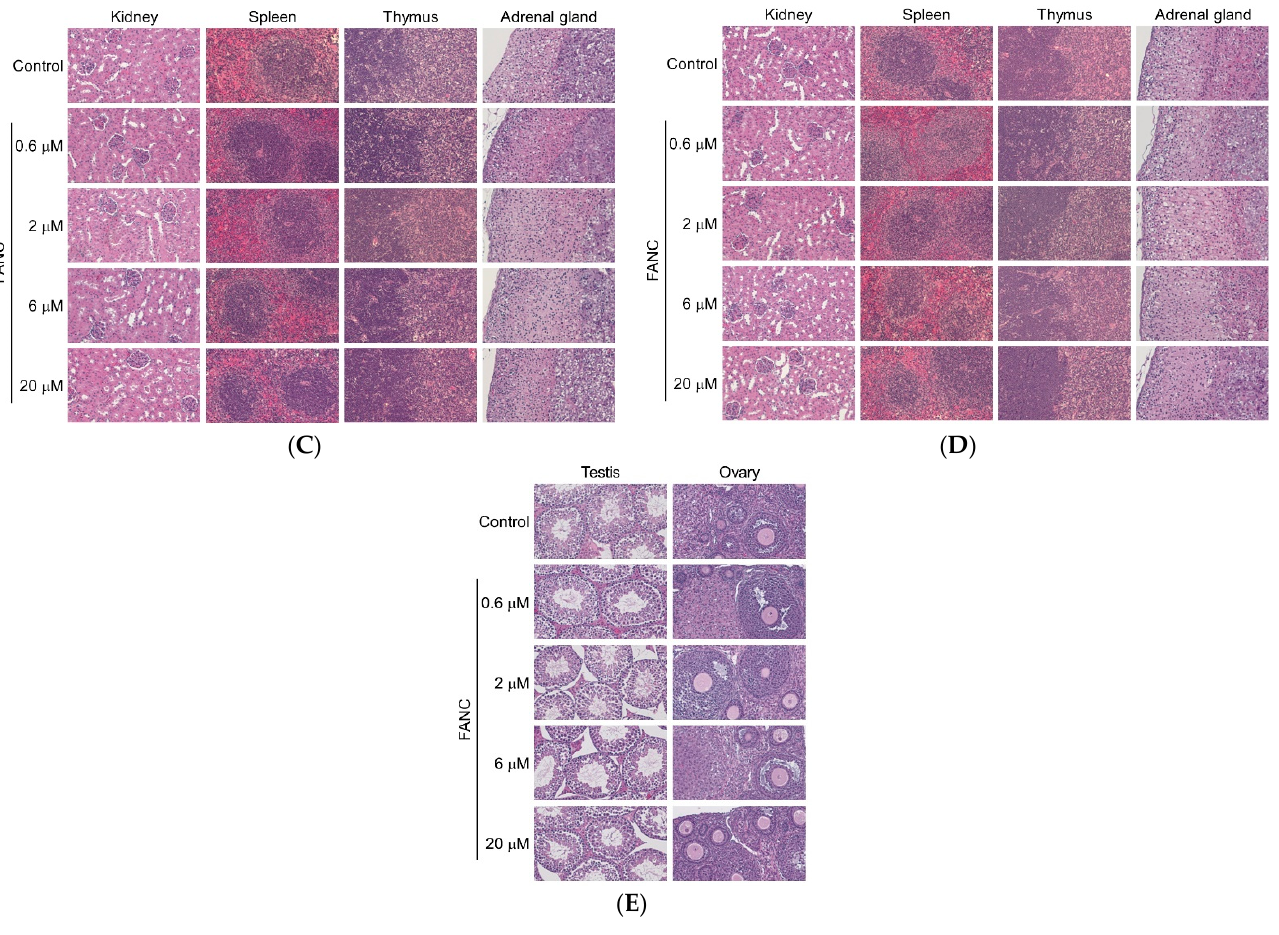
Table 1. Changes of hematological parameters of ICR mice after feeding the FANC for 14